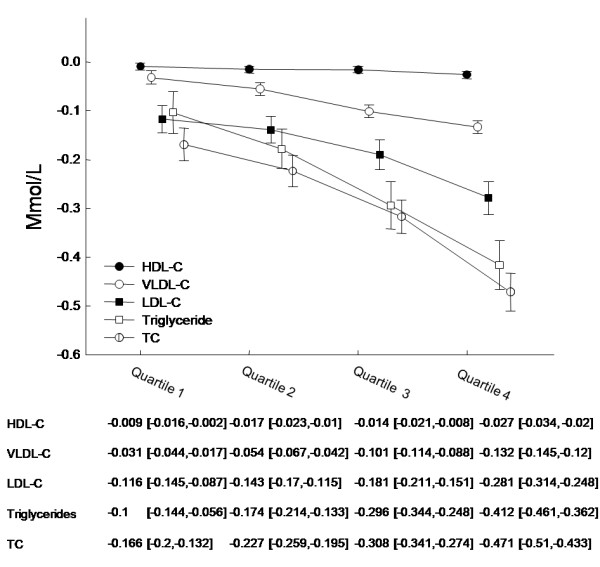
Mean lipid changes in patients with T2D according to BMI reduction quartiles. Lipid changes in patients with T2D stratified according to BMI reduction quartile (1-4). Quartile 1 represents the least reduction in BMI whereas quartile 4 represents the greatest. Mean lipid values are listed for each quartile with 95% confidence intervals. All values are measured in mmol/L. 13 patients with unknown risk category were excluded.